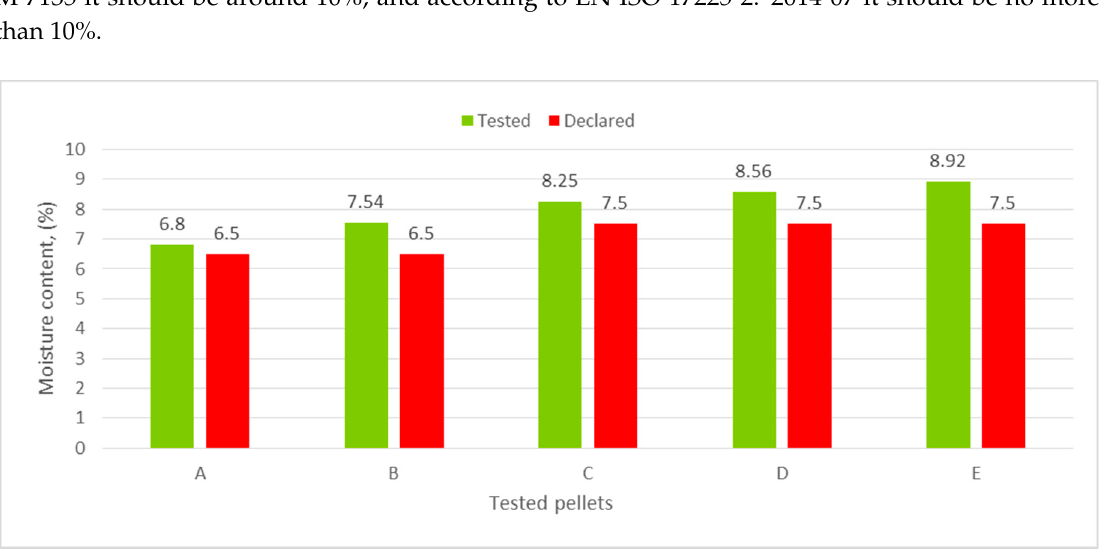
Figure 3. Comparison of the average moisture content in the samples and values declared by the producers printed on the packaging.